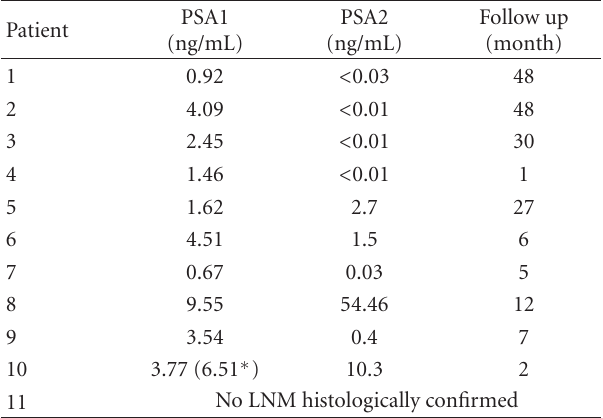
Table 2: PSA development after secondary resection of LNM without adjuvant